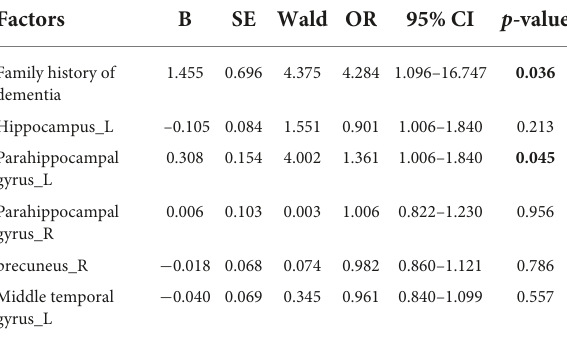
TABLE 4 Multivariate logistic regression analyses of risk factors in patients with